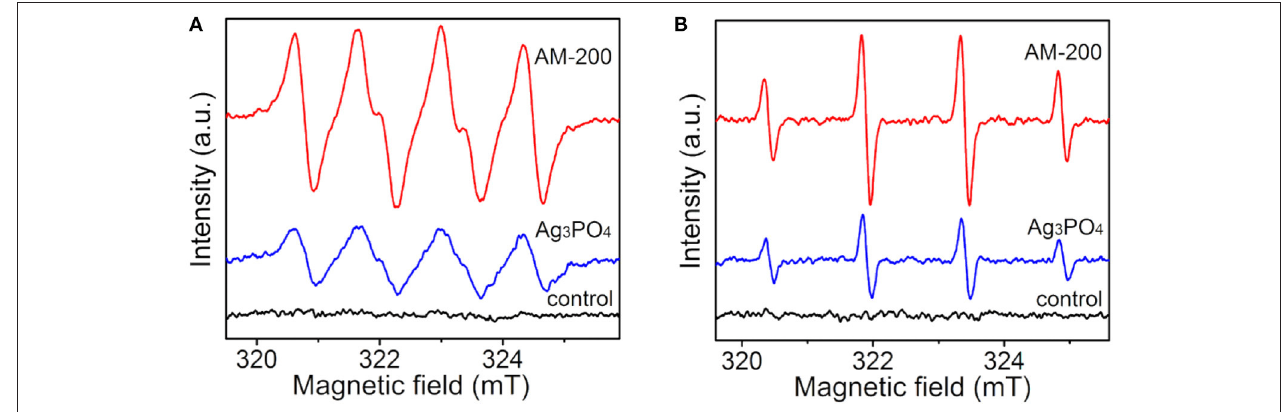
FIGURE 6 | ESR spectra of radical adducts trapped by DMPO in methanol (A) and aqueous (B) dispersions of Ag 3 PO 4 and AM-200 under light irradiation.